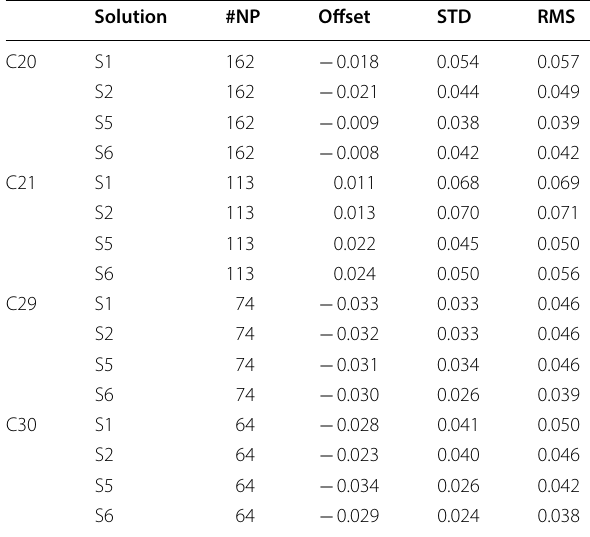
Table 4 SLR check results/m Solution